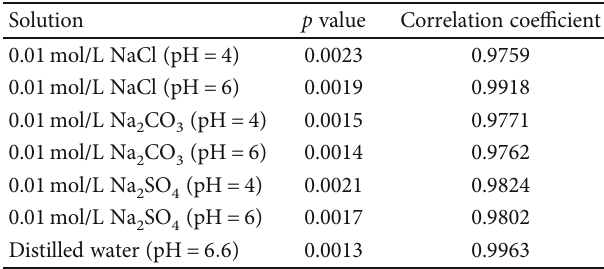
Figure 2: Change patterns of the peak strength of limestone under coupled MHC e ff ects in solutions of di ff erent contents. Table 5: Strength damage parameter and correlation coe ffi cient of the limestone under coupled MHC e ff